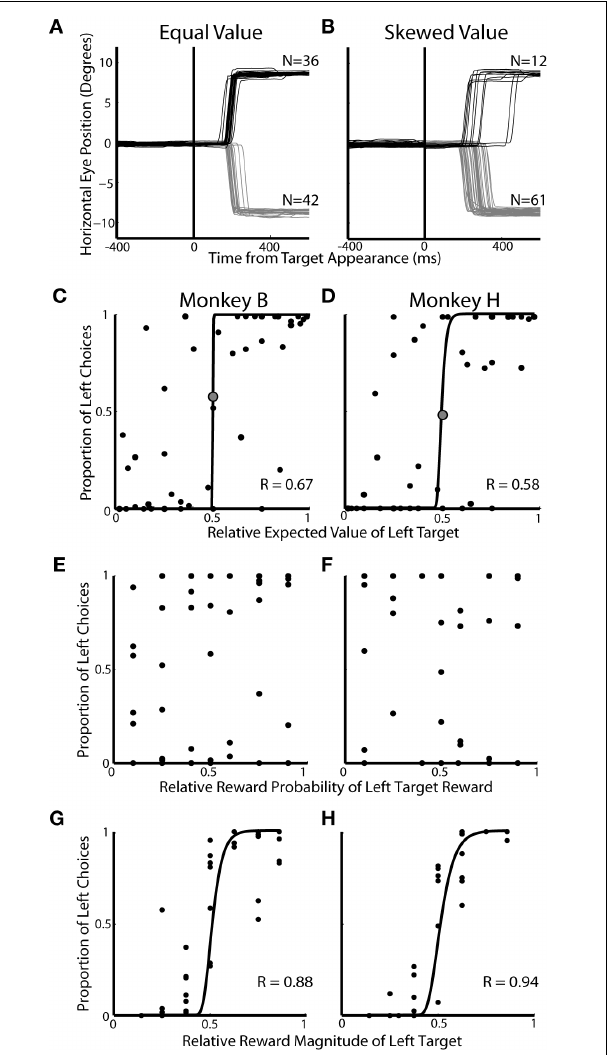
FIGURE 2 | Influence of decision factors on choice preference during two-target trials. All data is taken from the two-target trials of Experiment #1. (A,B) Individual eye traces for equal value (50% left probability/50% left reward magnitude) and skewed value (50% left probability/62% left reward magnitude) blocks of trials. Each line represents horizontal eye position on a single trial. (C,D) Influence of relative expected value on saccadic choices. Each dot represents 50–75 trials of a particular prospect collapsed over two to three blocks of trials. Correlation coefficients ( R ) are based on least square fits of a logistic function (black lines).The large gray dot indicates the equal value prospect. (E,F) Influence of relative reward probability on saccadic choices. (G,H) Influence of relative reward magnitude on saccadic